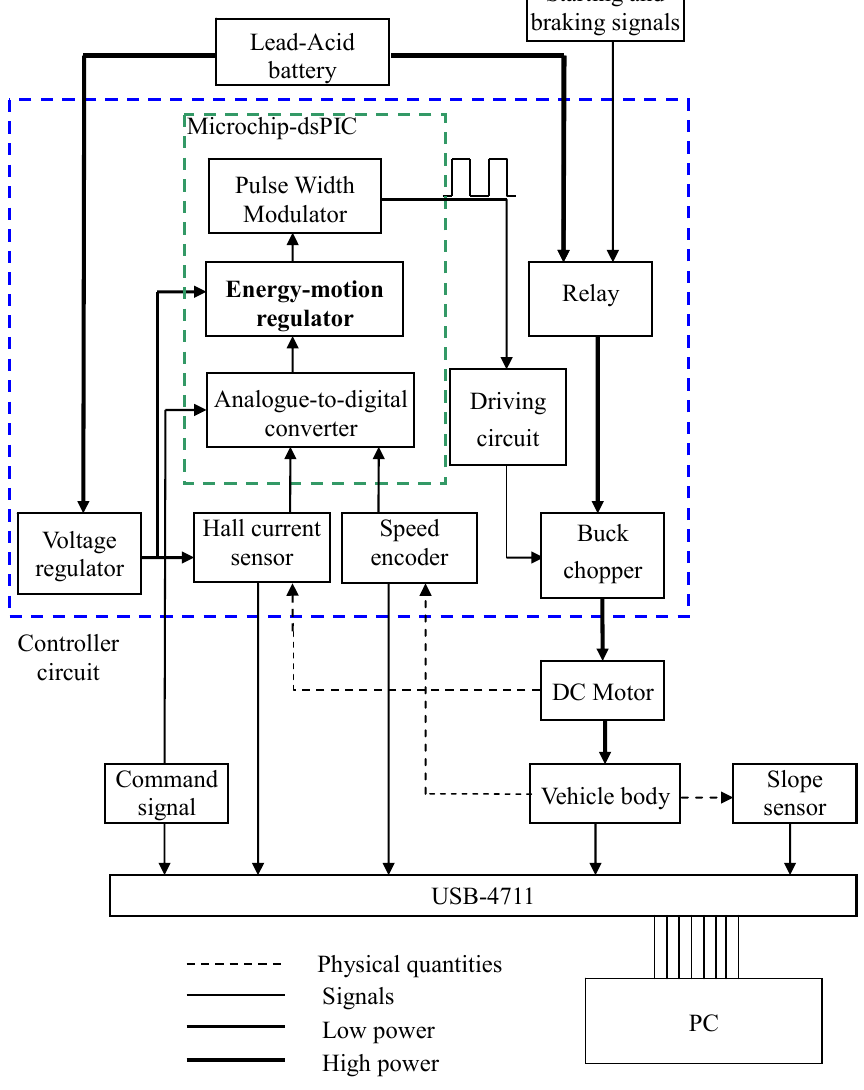
Figure 8. Means plus functions of the controller and